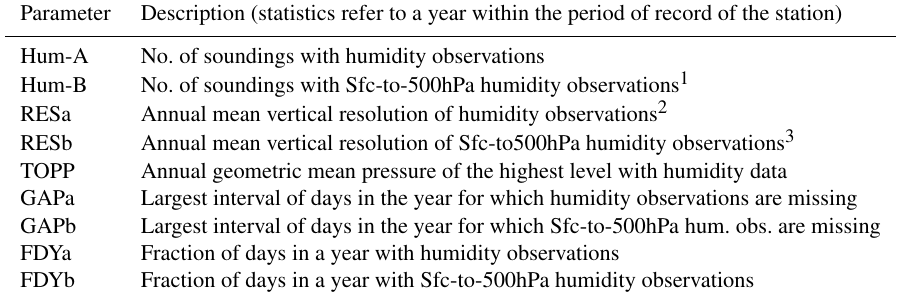
Table 2. Parameters of humidity completeness for each IGRA-RS station and year. Parameter Description (statistics refer to a year within the period of record of the station) Hum-A No. of soundings with humidity observations Hum-B No. of soundings with Sfc-to-500hPa humidity observations 1 RESa RESb TOPP Annual geometric mean pressure of the highest level with humidity data GAPa Largest interval of days in the year for which humidity observations are missing